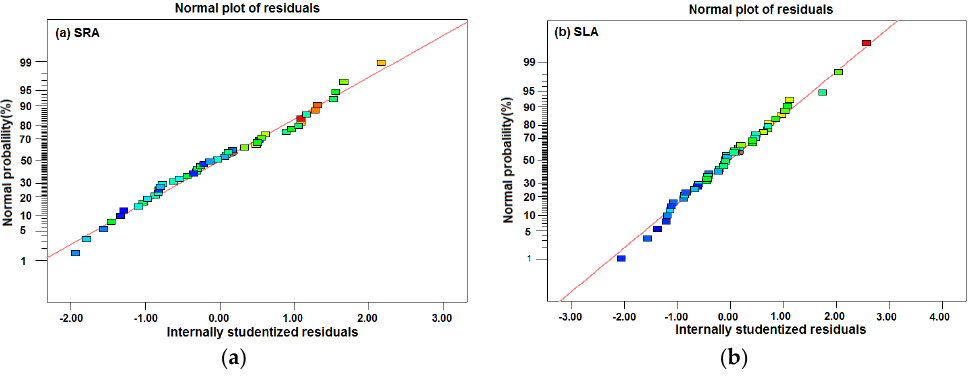
Figure 8. Normal plot of residuals for: ( a ) SRA; and ( b ) SLA.